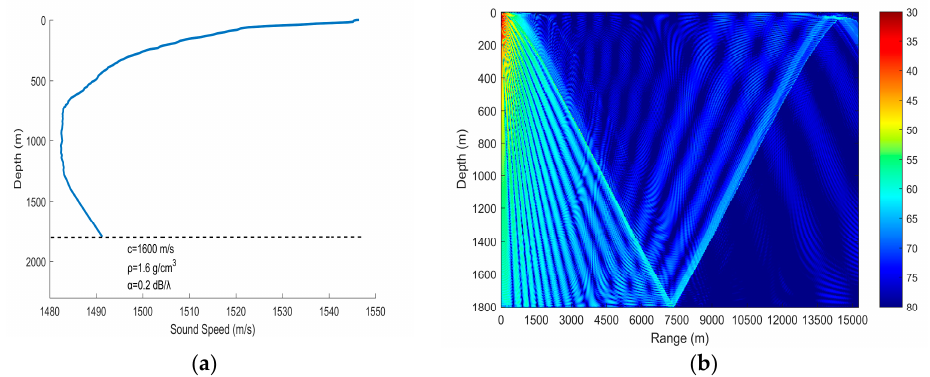
Figure 4. ( a ) Measured sound speed profile; ( b ) Calculated transmission loss (the source depth is 30 m and the frequency is 350 Hz).